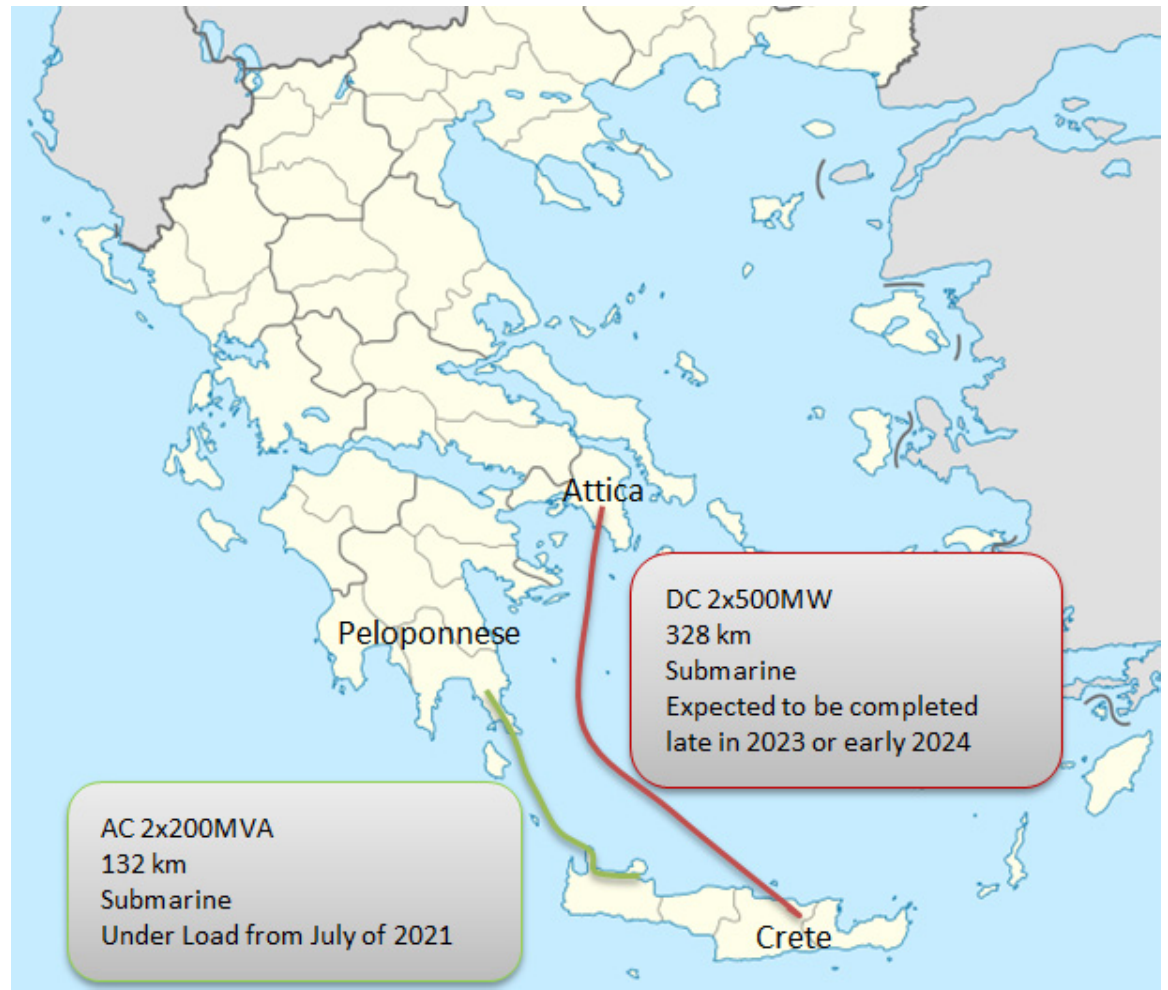
Figure 1. The AC and DC interconnections of Crete with mainland.